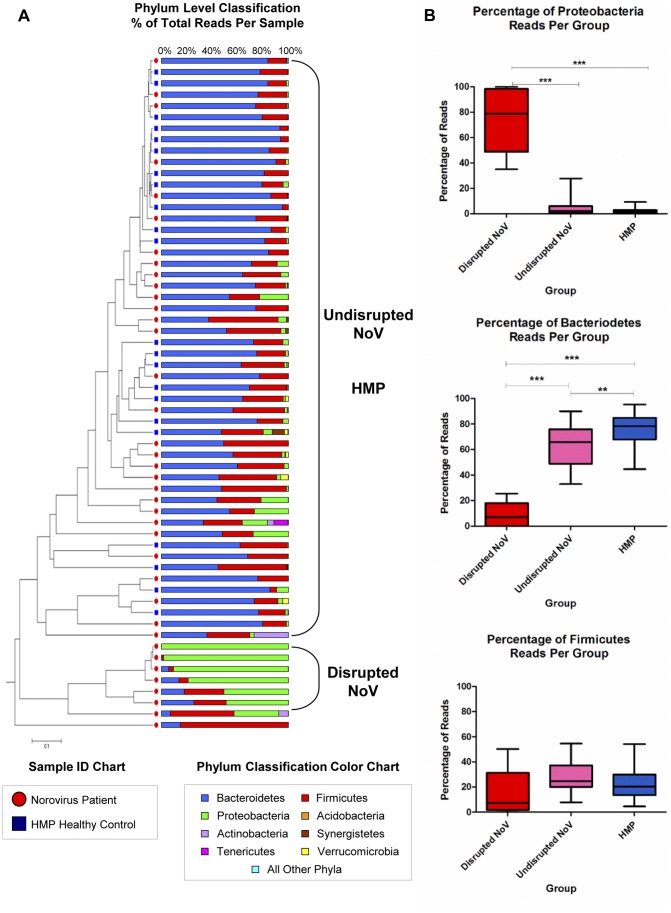
Patients infected with Norovirus show differential disruption.A) Dendrogram showing the phylogenetic relationship between samples, as calculated by the Yue and Clayton dissimilarity index at a 3% OTU level was paired with a phylum-level classification of the communities for each individual. B) Comparisons between different groups by a one-way ANOVA test showed that the disrupted patients have significantly less Bacteroidetes and significantly more Proteobacteria compared to the undisrupted and HMP patients. Abbreviations: HMP = Healthy control patient from the Human Microbiome Project.